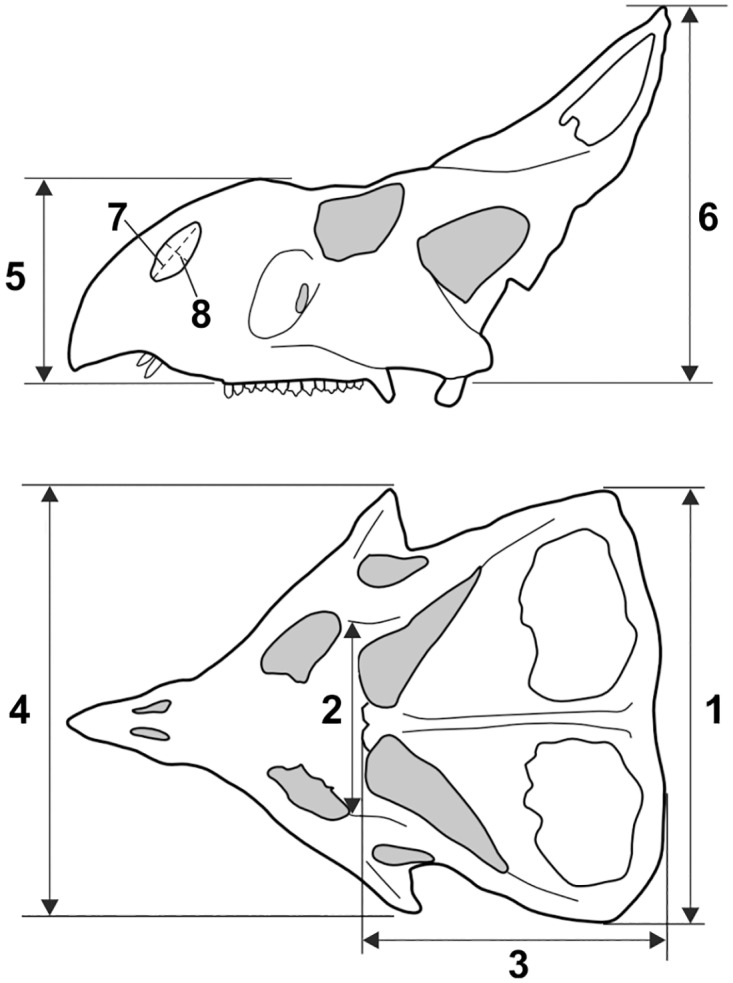
Linear measurements measured on skull.Redrawn following the measurement standards originally in Dodson [25]. The numbers of measurements corresponds to those reported in Table B in S1 File.